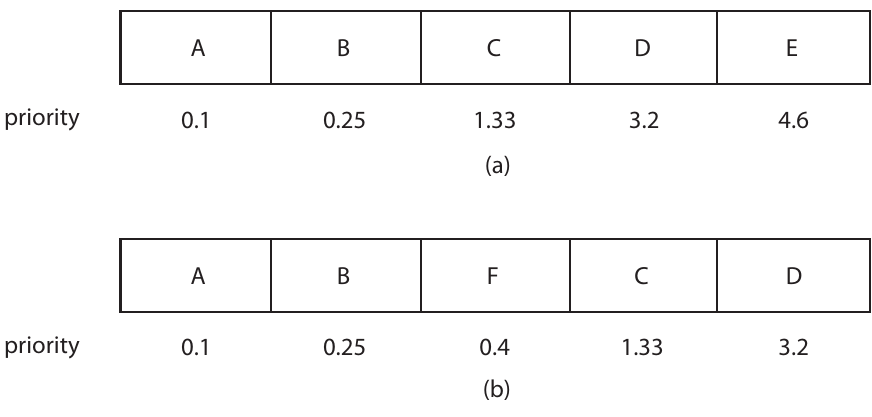
Figure 13. Bounded priority queue for k-nearest